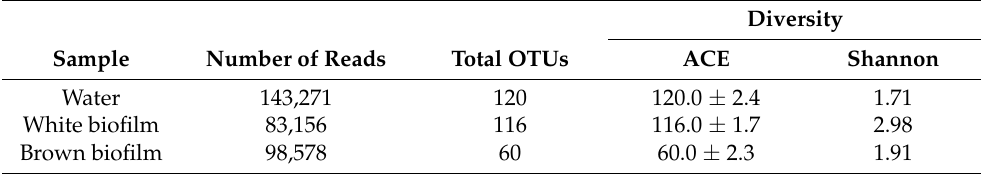
Table 3. Number of reads, OTUs, richness, and diversity indexes for water, white biofilm and brown biofilm samples from the Smrdljivec spring.